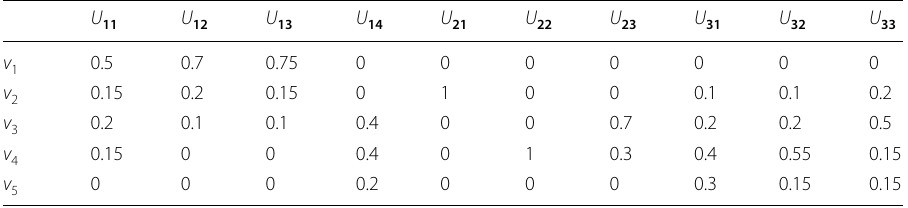
Table 5 Evaluation result of ironing operation